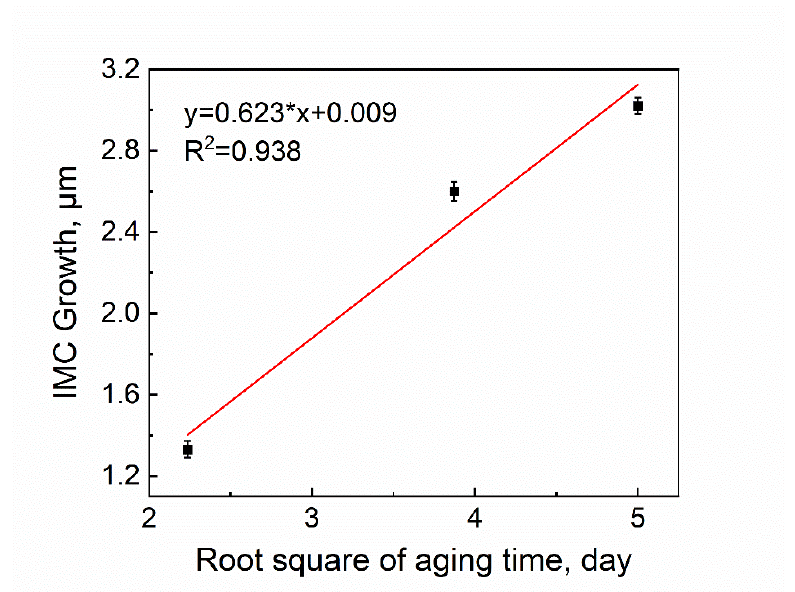
Figure 16. Linear relationship between the thickness of total IMC and the square root of aging days in the fully mixed solder joint.